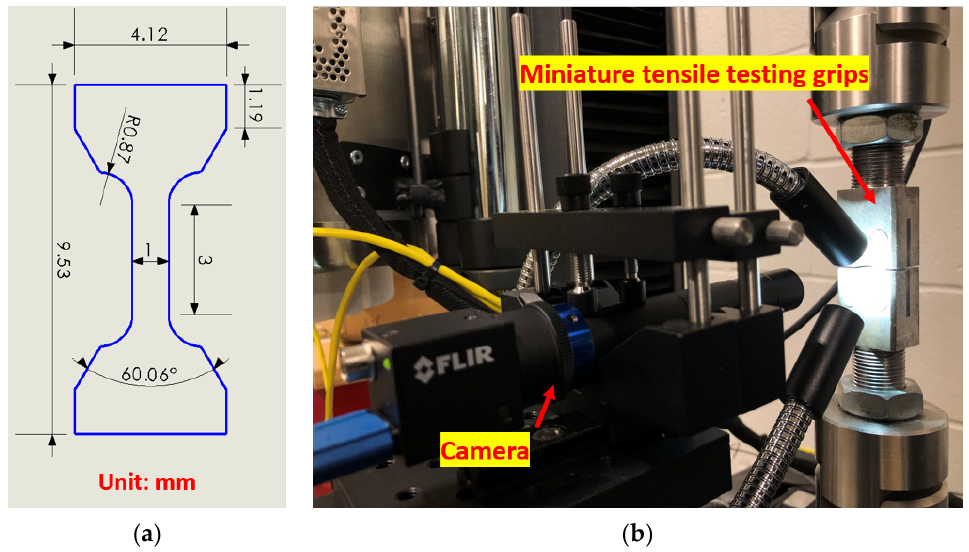
Figure 2. ( a ) The sketch of the miniature tensile specimen design. ( b ) The camera setup for